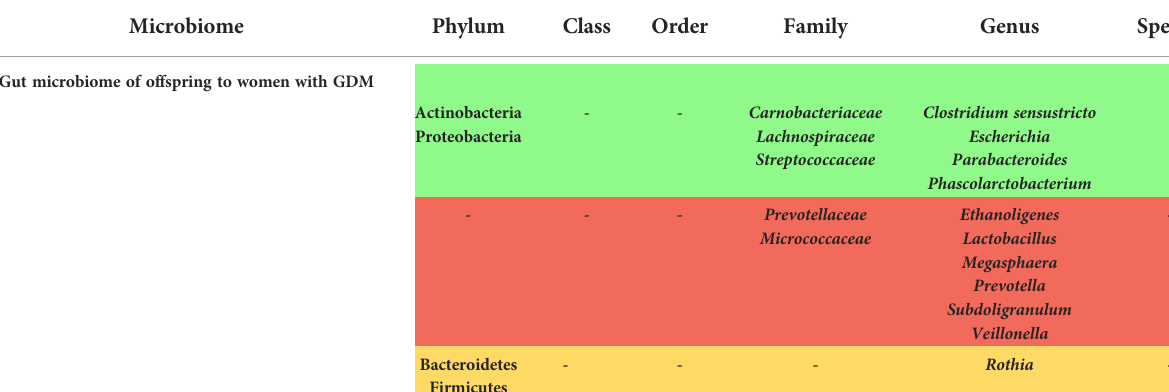
TABLE 2 Summary of the gut microbiome alterations in offspring to patients with GDM ( = Increased, = Decreased, = Variable).